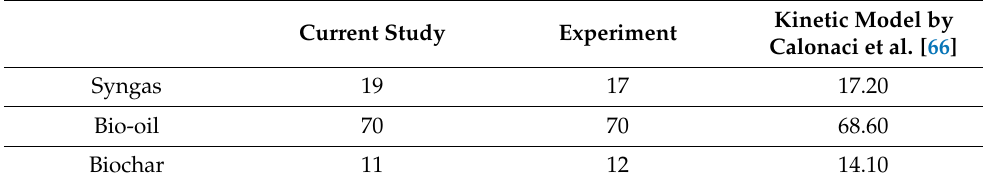
Table 12. Comparison of product yields for pine–spruce–sawdust feedstock